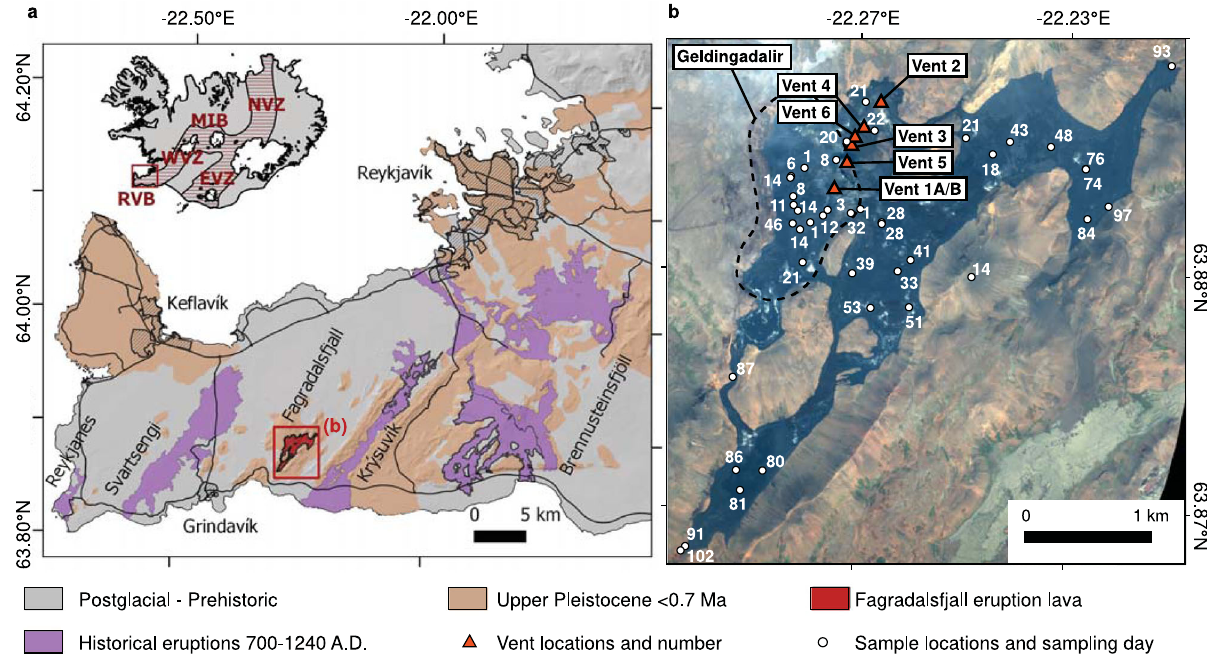
Fig. 1 The Fagradalsfjall eruption site on the Reykjanes Peninsula. a Inset shows the main rift zones on Iceland (EVZ = Eastern Volcanic Zone; MIB = Mid-Iceland Belt; NVZ = Northern Volcanic Zone; RVB = Reykjanes Volcanic Belt; WVZ = Western Volcanic Zone). Map of Reykjanes Peninsula shows historical (purple; late Holocene) and prehistoric (brown and grey; early Holocene, Postglacial and Pleistocene) eruptions as well as the extent of the lava fi eld of the 2021 Fagradalsfjall eruption (red). The base map is based on data from the National Land Survey of Iceland (www.lmi.is) with geological data after ref. 48 . b Close-up satellite map of the red box in panel (a) showing sampling locations numbered by the days since the start of the eruption (white dots). The positions of the eruptive vents are also marked (red triangles) and numbered in order of appearance. Background image is an orthophoto generated with the Plèiades tri-stereo satellite